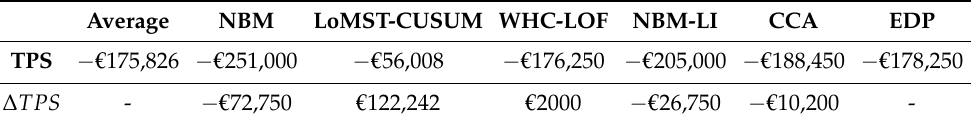
Table 6. Total Prediction Savings (TPS) and improvement over EDP ( ∆ TPS ) for each model for training period.